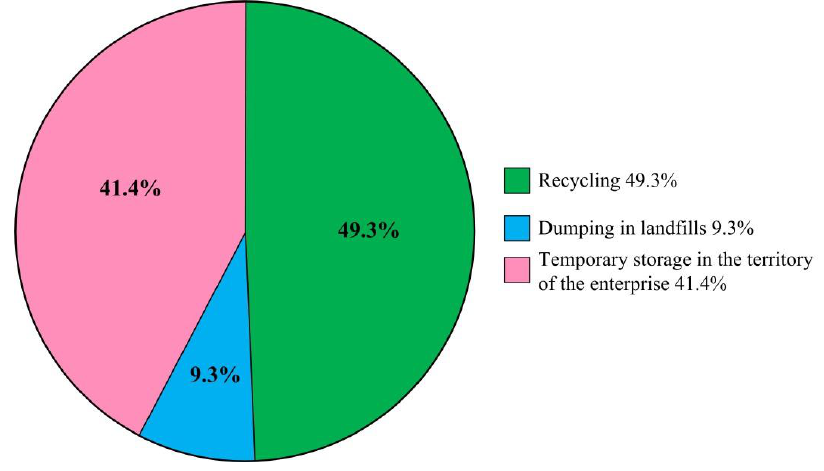
Figure 1. Industrial waste recovery structure in the Russian Federation [3].